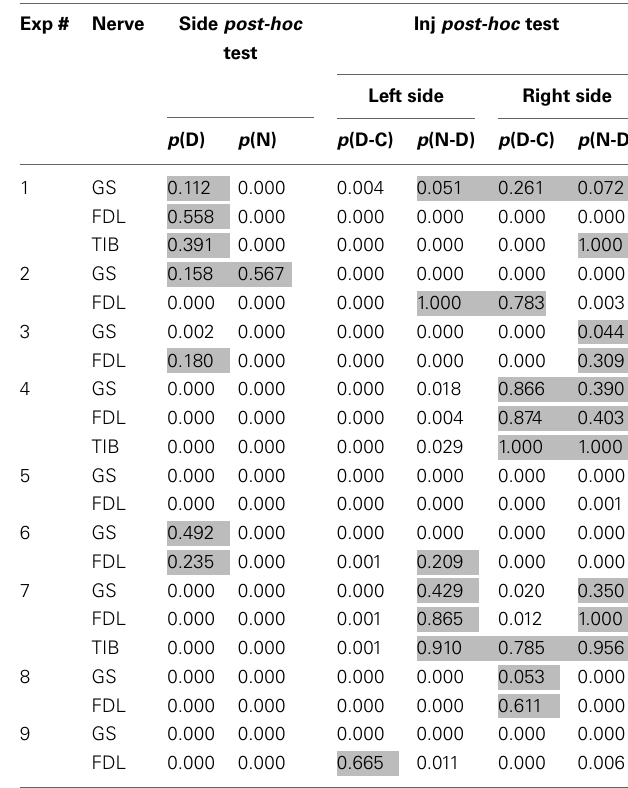
Table 1 | ANOVA analysis of the data obtained in all of the experiments.